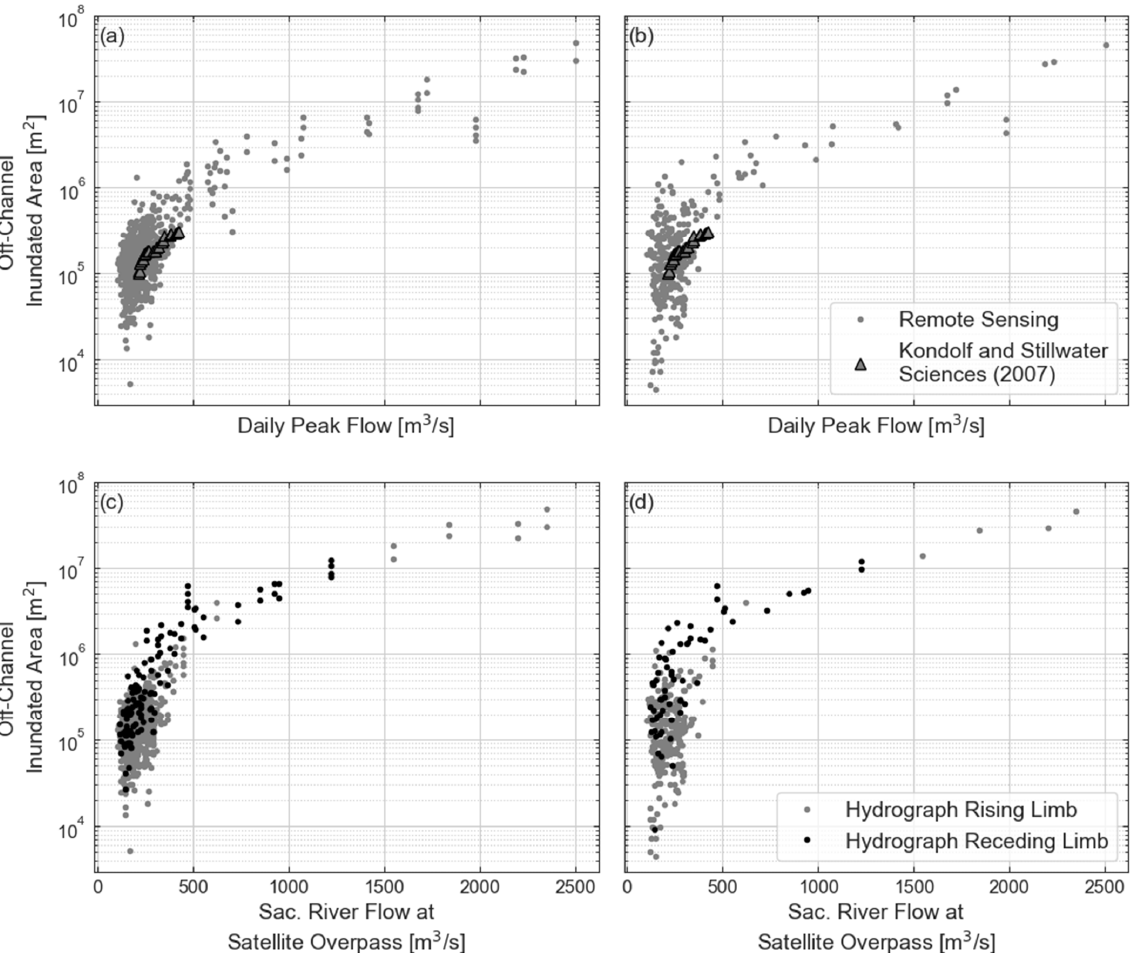
Figure 5. Computed shallow areas extent along the mid-Sacramento River for each high-flow event peak using ( a ) mNDWI with single and dynamic thresholds and ( b ) AWEI sh single threshold. Surveyed estimates by [18]are also included for comparison. Subplots ( c , d ) show computed off-channel inundated areas against flows at satellite overpass for each water index.